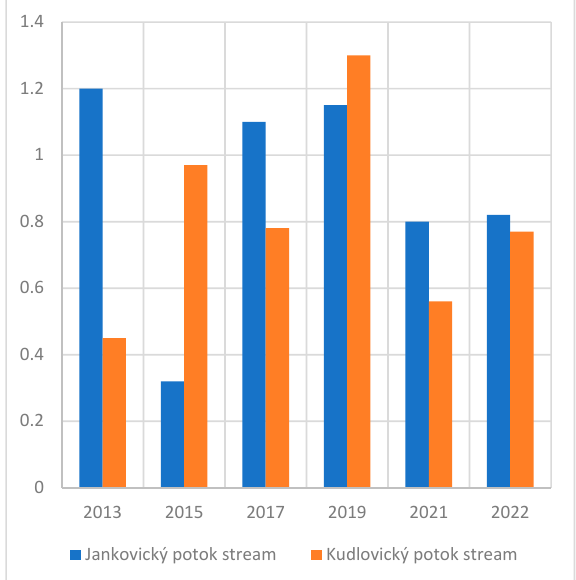
Figure 12. Comparison of larval densities of C. heros per 1m 2 of suitable sediment (y-axis) in individual years at the Jankovický potok stream site (stream affected by active forestry activity) and the Kudlovický potok stream site (natural stream without forestry activity).